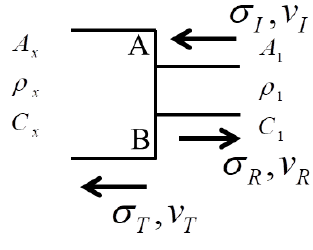
Figure 11. Schematic of wave reflection and transmission.